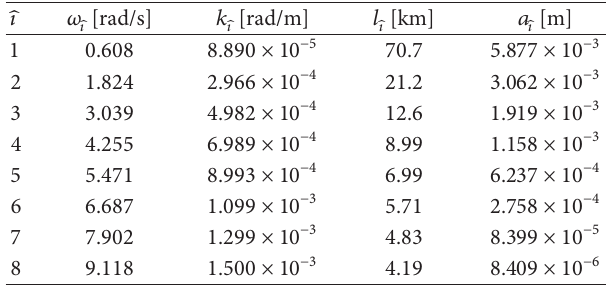
Table 1: Values for the first 8 incident modes; ℎ 1 = 4000 m, 𝑔 = 10 m/s 2 , and 𝑐 = 1500